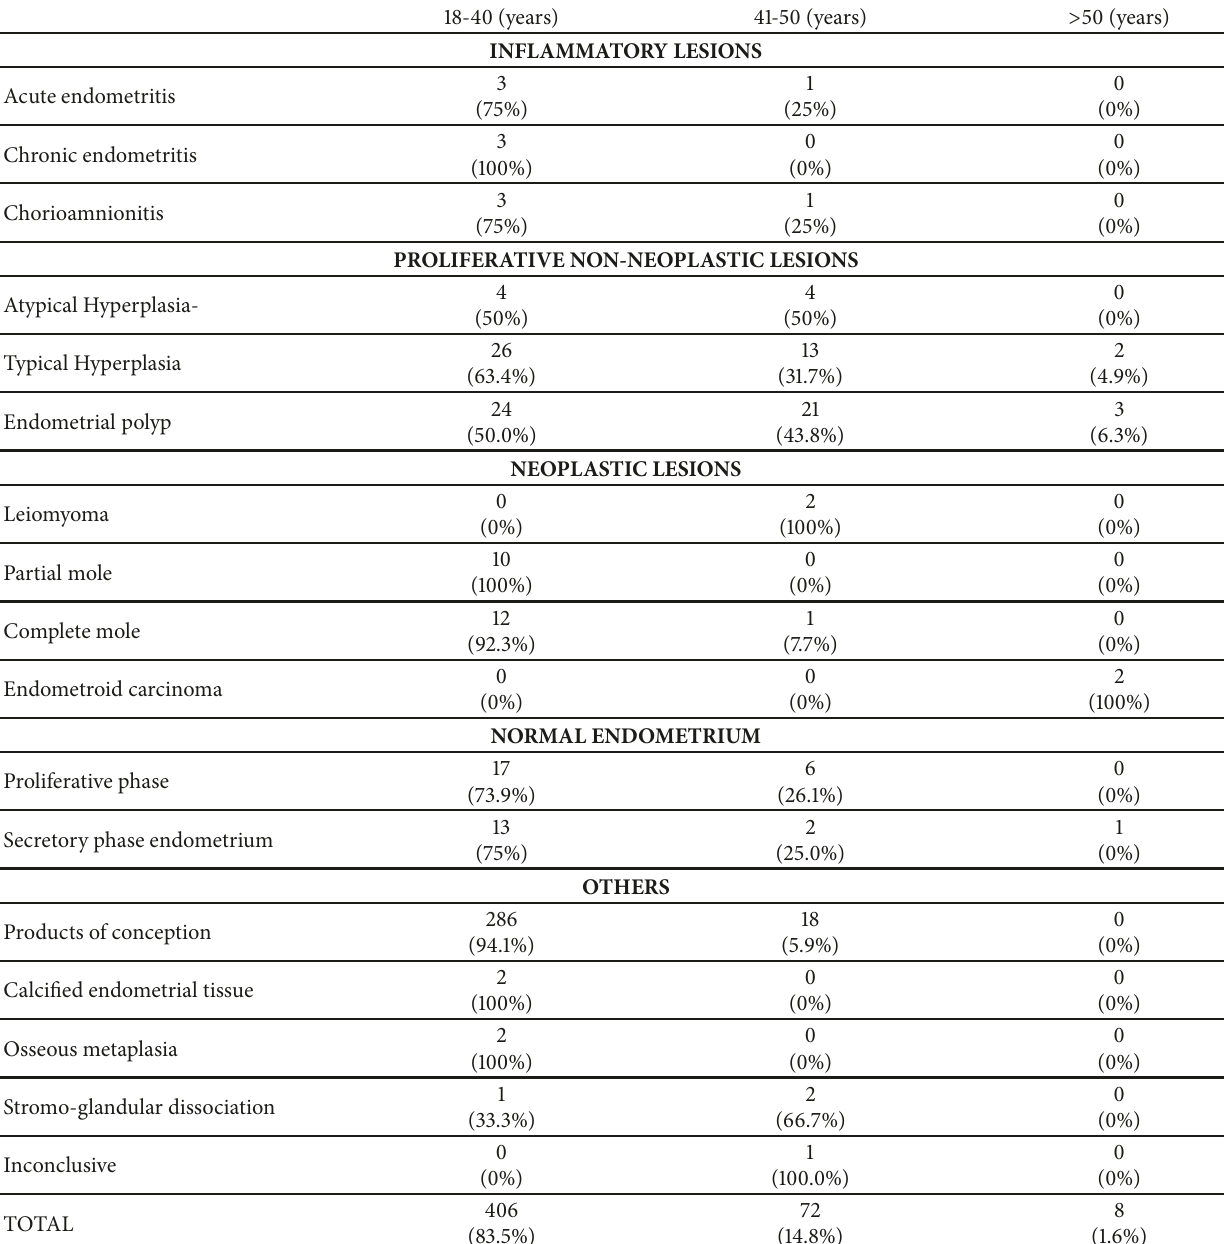
Table 1: List of various diagnosis and the corresponding age